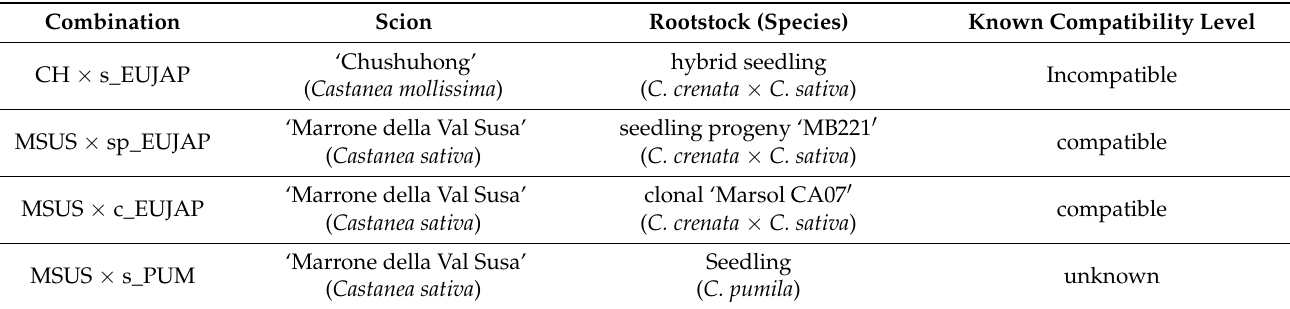
Table 1. Grafting combinations tested and the known level of